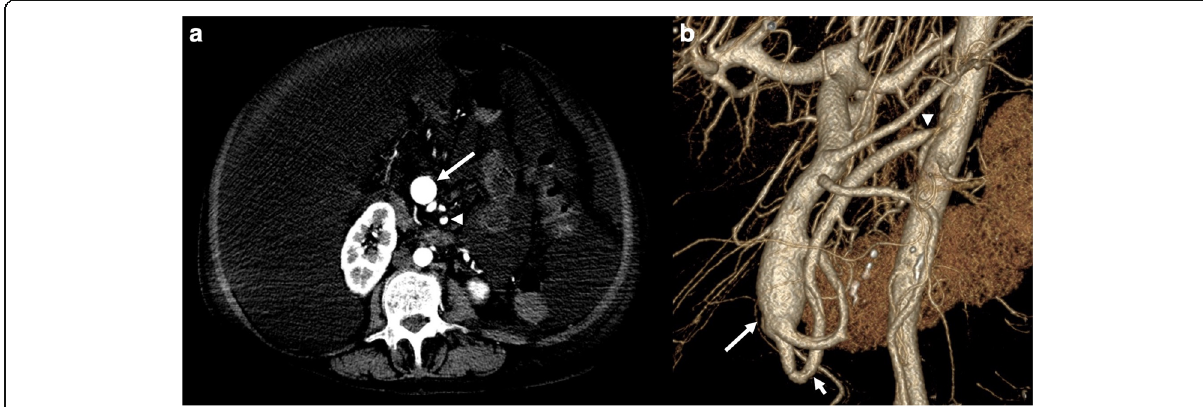
Fig. 1 Contrast-enhanced abdominal CT scan (arterial phase) of a superior mesenteric arteriovenous fistula (SMAVF) ( a ) Axial image shows a SMAVF (arrowhead) feeding into a dilated superior mesenteric vein (arrow) ( b ) 3D reconstruction shows the SMAVF (short arrow) connecting the superior mesenteric artery (arrowhead) to an ectasia of the superior mesenteric vein (long